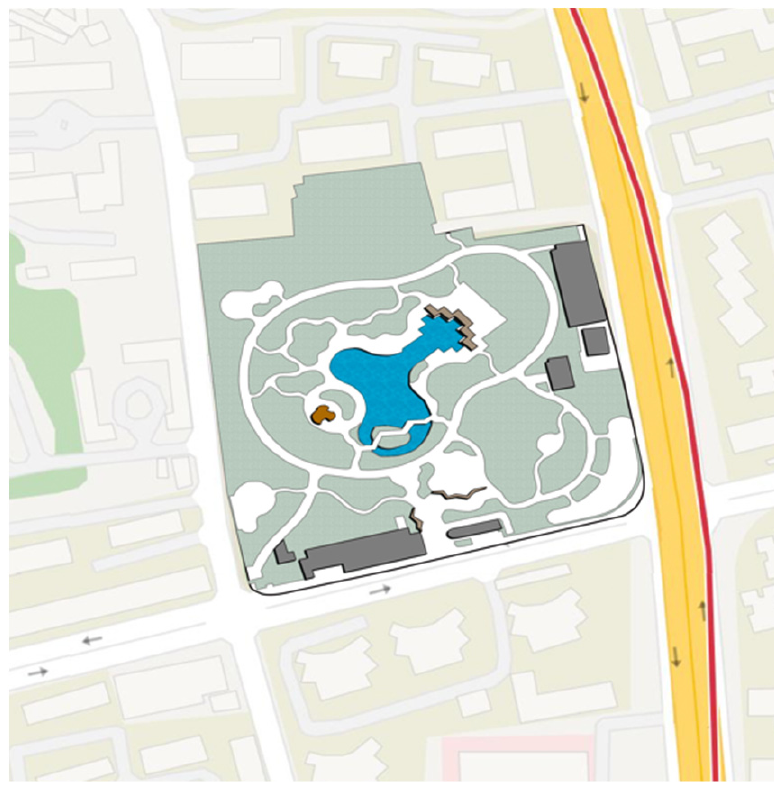
Figure 5. Map of Sanquan Park.